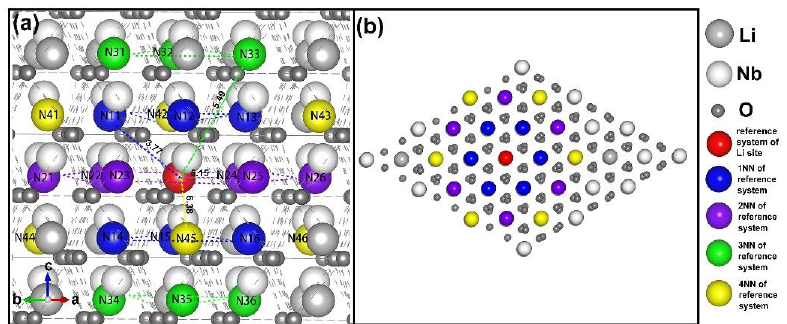
Figure 2. The vicinity analysis of the lithium (Li) sub-lattice. ( a ) The red ball present dopant in a Li sub-lattice. In addition, blue, purple, green, and yellow balls indicate the INN, 2NN, 3NN, and 4NN sites from the dopant site. The distance between the dopant site and the nearest neighbor sites are given. Its unit is Å . ( b ) is the top view of ( a ) along the opposite direction of the c axis.